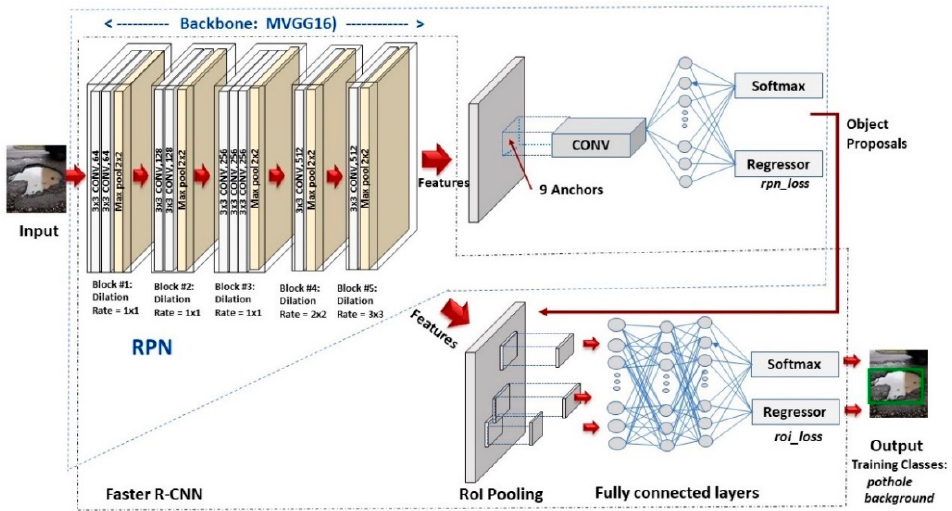
Figure 3. Faster R-CNN with modified VGG16 (MVGG16).